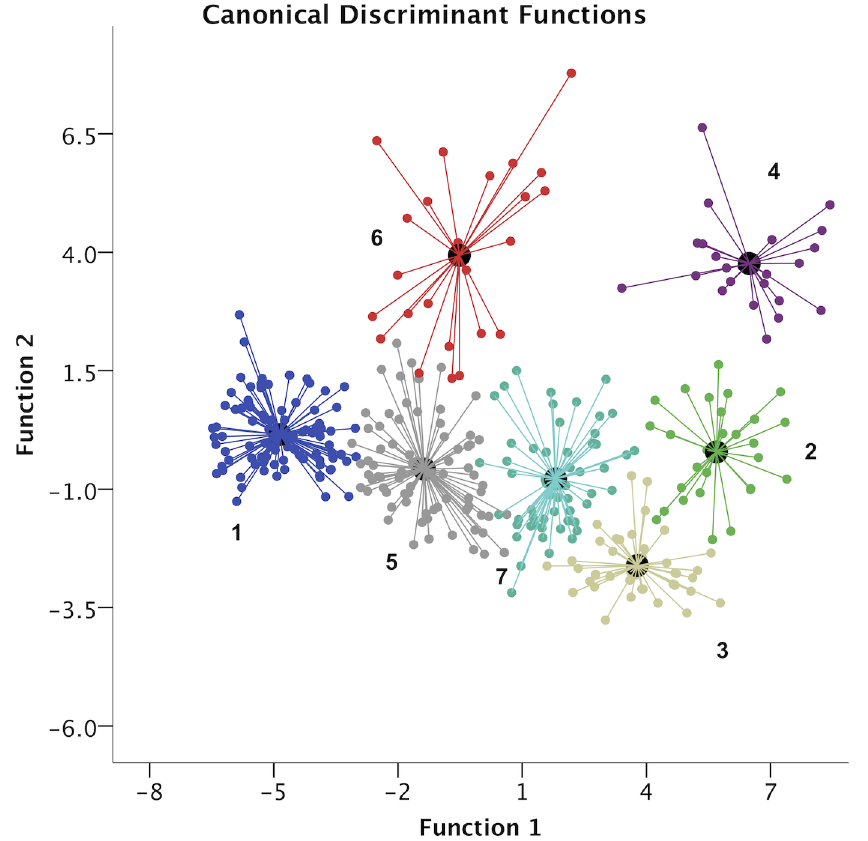
Fig 3. Territorial map from the cases and created